Question: Which visualization type does this figure use?
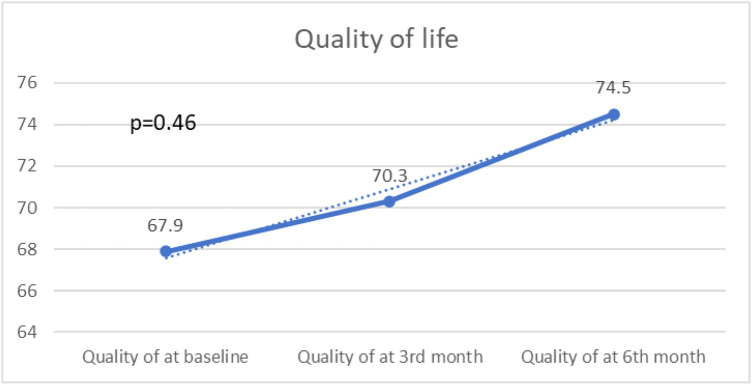
Answer: line